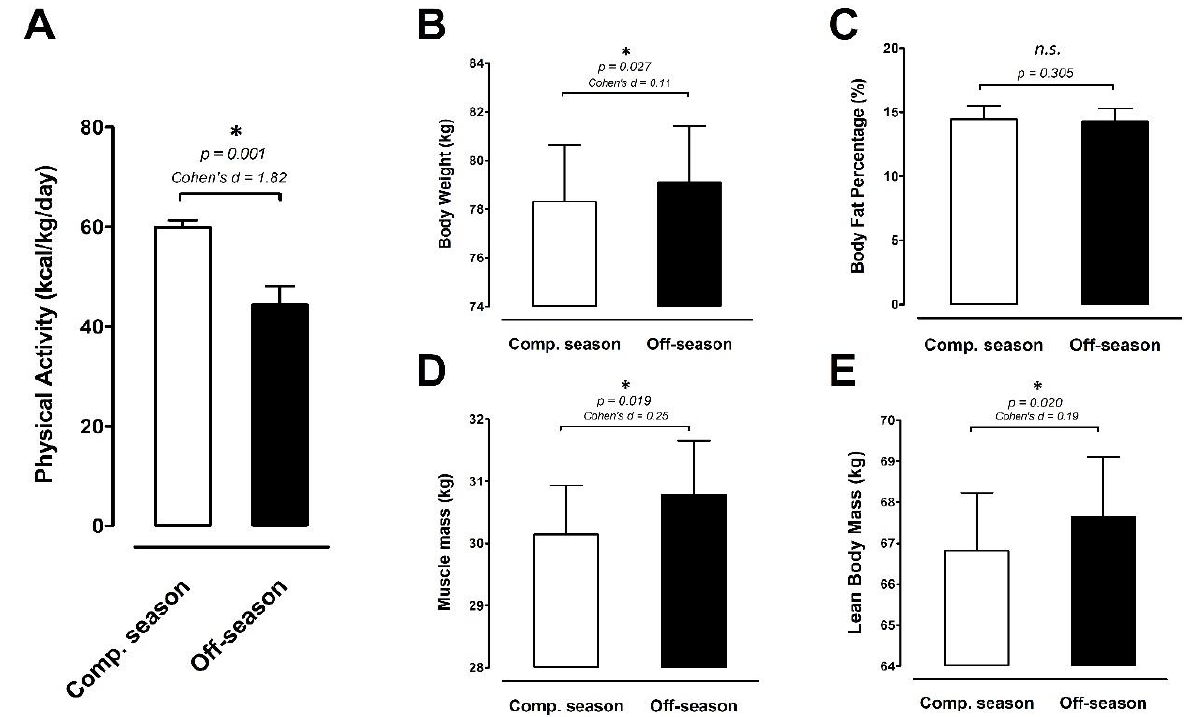
Figure 3. Physical activity and body composition. ( A ) Physical activity, ( B ) body weight, ( C ) body fat percentage, ( D ) muscle mass, and ( E ) lean body mass were measured at the competitive season and off-season (competitive season, open bar; off-season, black bar). Data are expressed as Mean ± S.E.M. * denotes significant difference between two phases ( p < 0.05). Comp. season: competitive season (CS), off-season (OS).